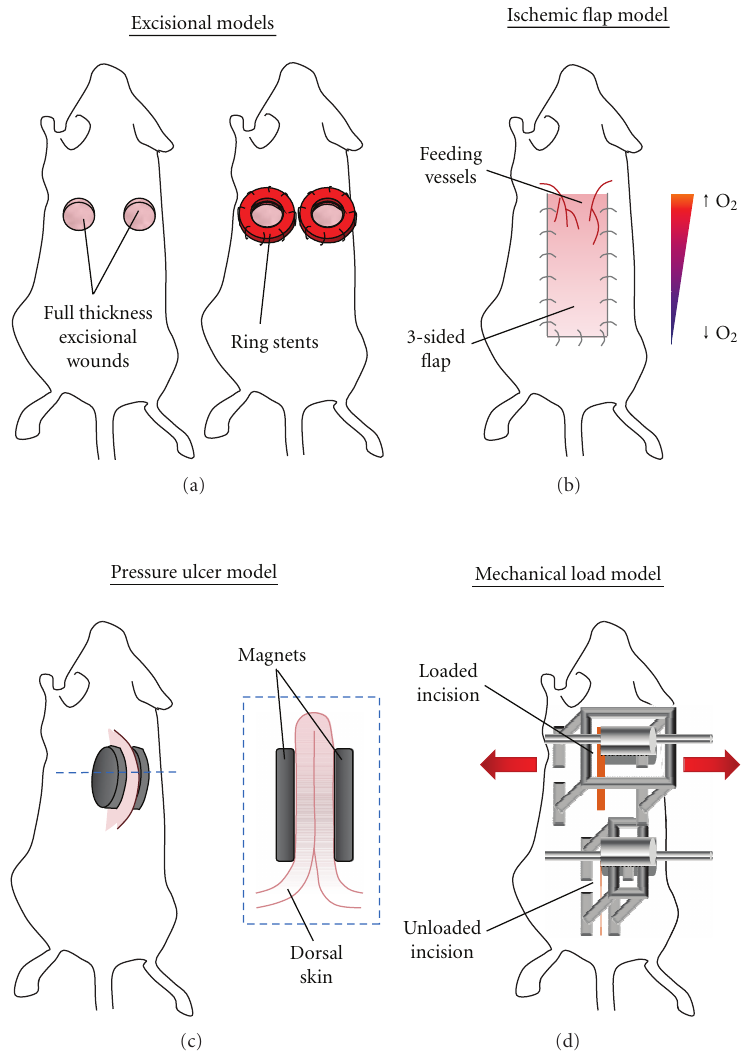
Figure 1: Surgical mouse models of cutaneous disease. (a) Full thickness excisional wound models are commonly used to assess numerous components of wound healing in vivo . Contraction of the underlying panniculosus carnosus can be minimized with a splinted wound model (right) whereby wound repair proceeds mainly through granulation tissue formation and re-epithelialization similar to human skin repair. (b) The ischemic flap model produces a controlled gradient of ischemia based on the number and location of feeding blood vessels. Skin regions furthest from the vessel/s are the most ischemic. (c) Cyclical pressure can be applied with opposing magnets and interpositioned skin to mimic reperfusion/ischemia injury thought to drive pressure ulcer pathophysiology. (d) The application of exogenous mechanical loading to mouse incisions results in increased wound fibrosis similar to human hypertrophic